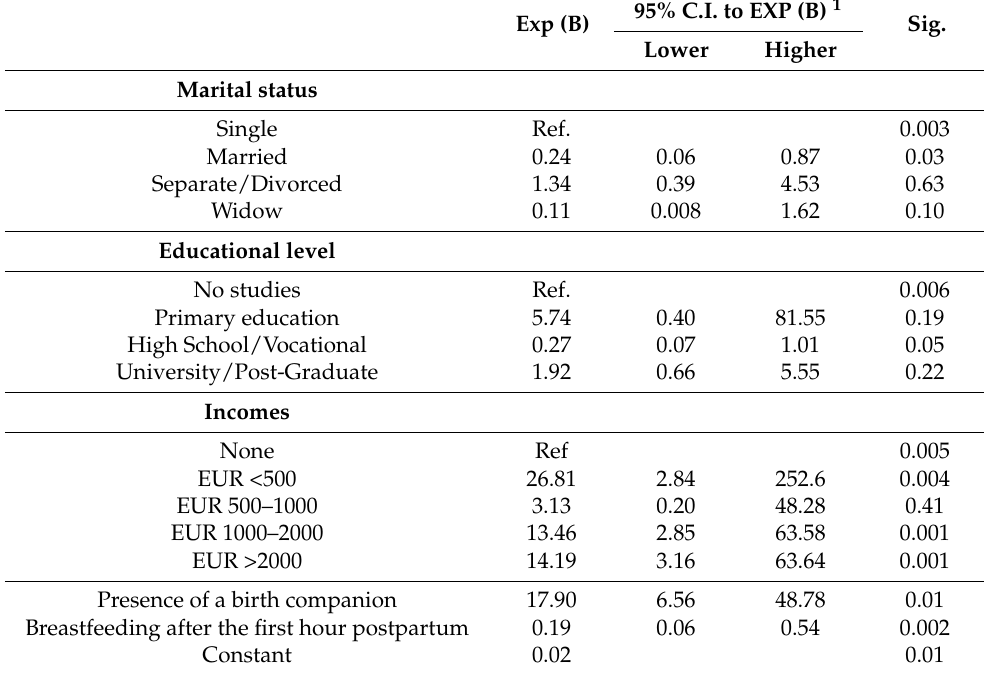
Table 4. Binary logistic regression model for